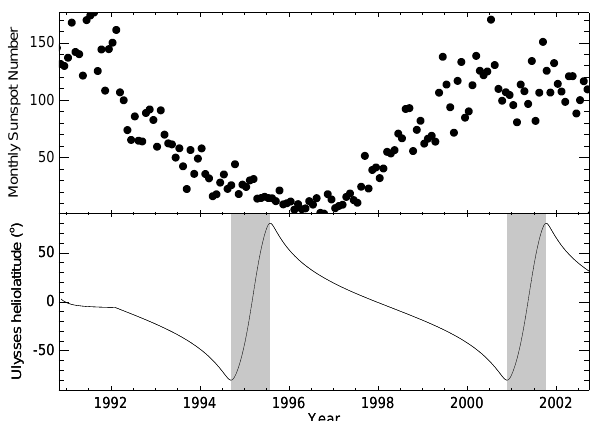
Fig. 1. Top: monthly sunspot numbers from the U.S. National Geo- physical Data Center. Bottom: the heliolatitude of Ulysses. The spacecraft’s two fast latitude scans are